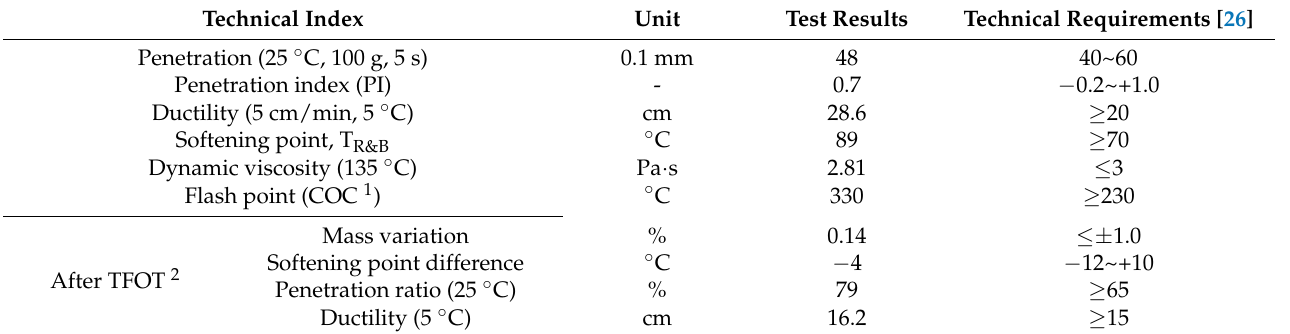
Table 1. Technical indices of SBS modified asphalt binder.